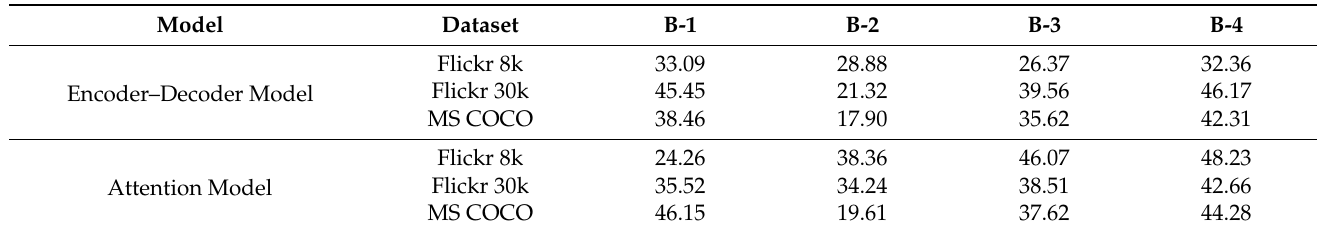
Table 6. Performance comparison based on different BLEU scores on Flickr 8k, Flickr 30k and MS COCO datasets using the encoder–decoder model and attention model.